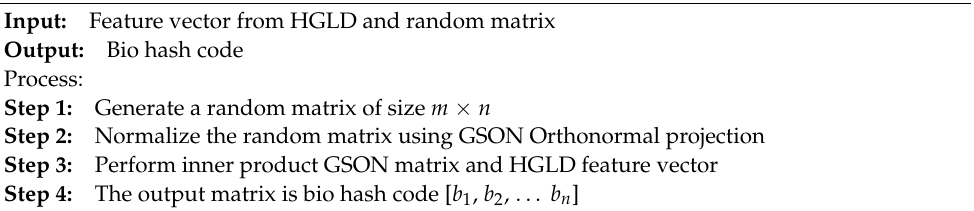
Algorithm 1 : Generation of Bio Hash Code through the Bio Hash Function Input